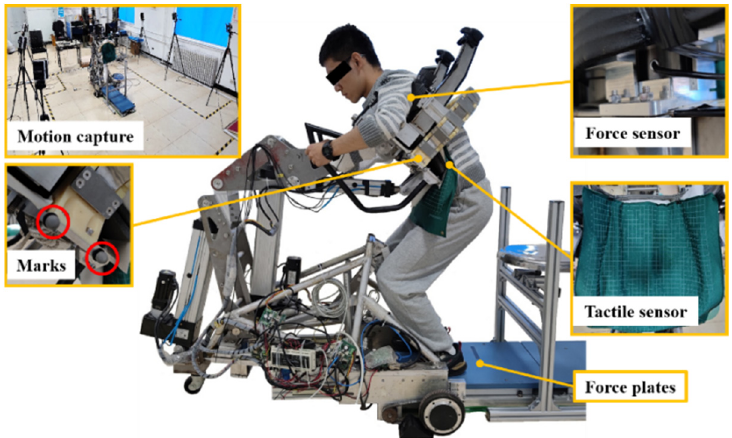
Figure 2. The measurement when the piggyback nursing-care robot lifted a subject.